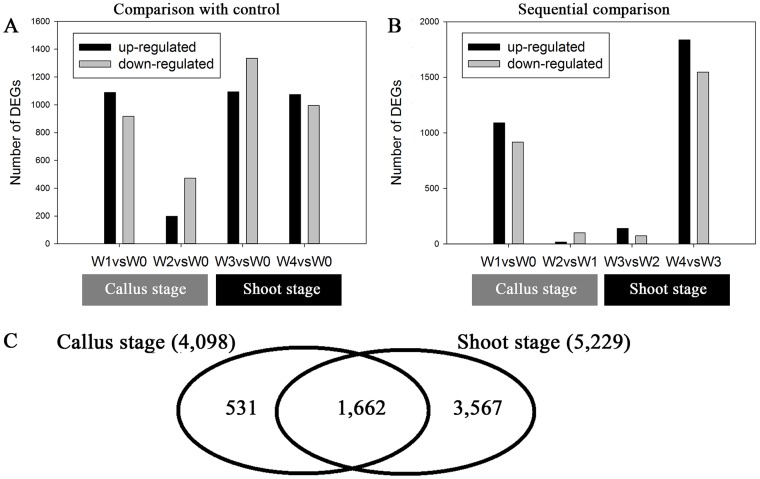
Histogram and Venn diagram of DEGs during in vitro organogenesis.Differential expression was calculated by comparison with the pre-induction stage (control) (A) and with the prior sampling point (B). The DEGs were identified using DESeq. The Venn diagram shows specifically or commonly expressed DEGs during the callus and shoot stages (C).